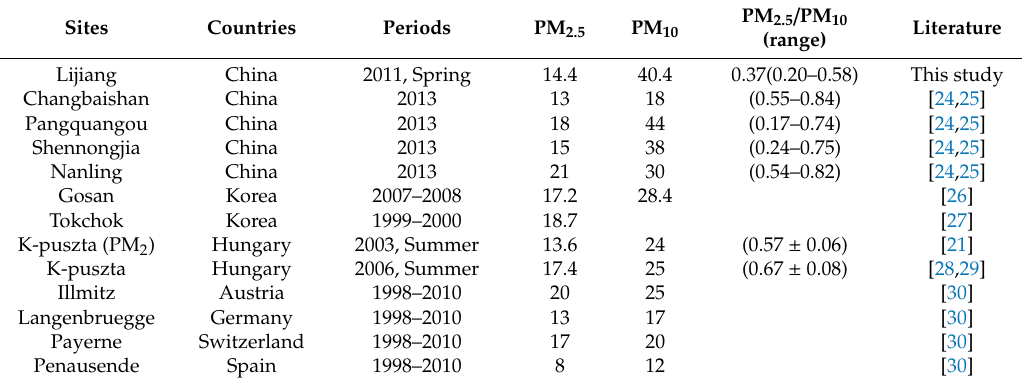
Table 2. PM 10 and PM 2.5 concentrations and ratios at clean/rural sites (μg/m 3 ).